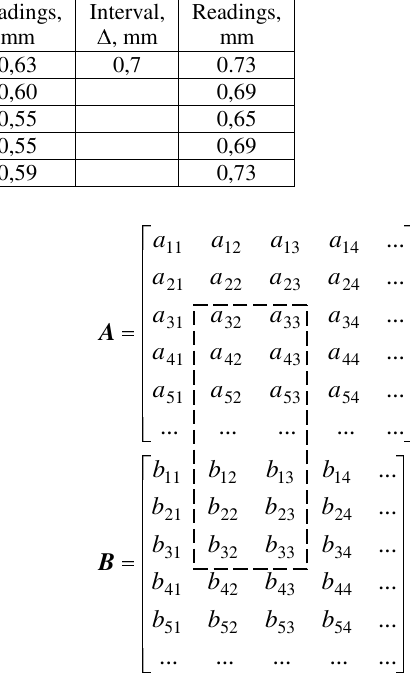
Fig 3. Digital output from search array of photosensors and analyzing window for subarrays selection A digital output from the photosensors presented in the form of matrixes A and B , from the view of etalon meter and calibrated meter respectively, are shown in Fig 3. The correlation coefficient is calculated from the subarrays that are selected by the analysing window. The error of the displacement (differences between the positions of bars on the meters) is determined by the local correlation coefficient. Such operations are performed as follows: • Preliminary correlation coefficient calculation at the beginning, middle and the end part of the meters using the formula (1); • Shift of the subarray B at the predetermined pitch ∆ and repeating an operation as described above; • t ∆ investigation region ± k , where k = 1, 2, 3, t